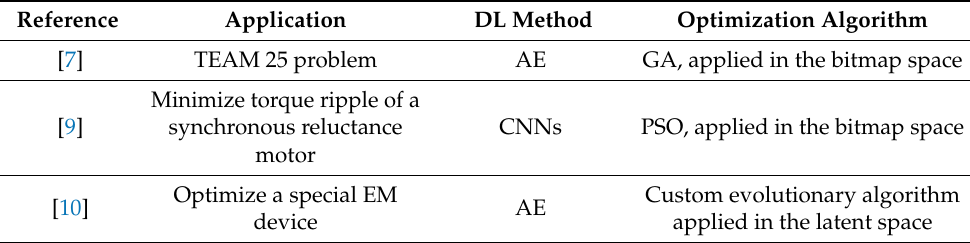
Table 1. Main aspects of related